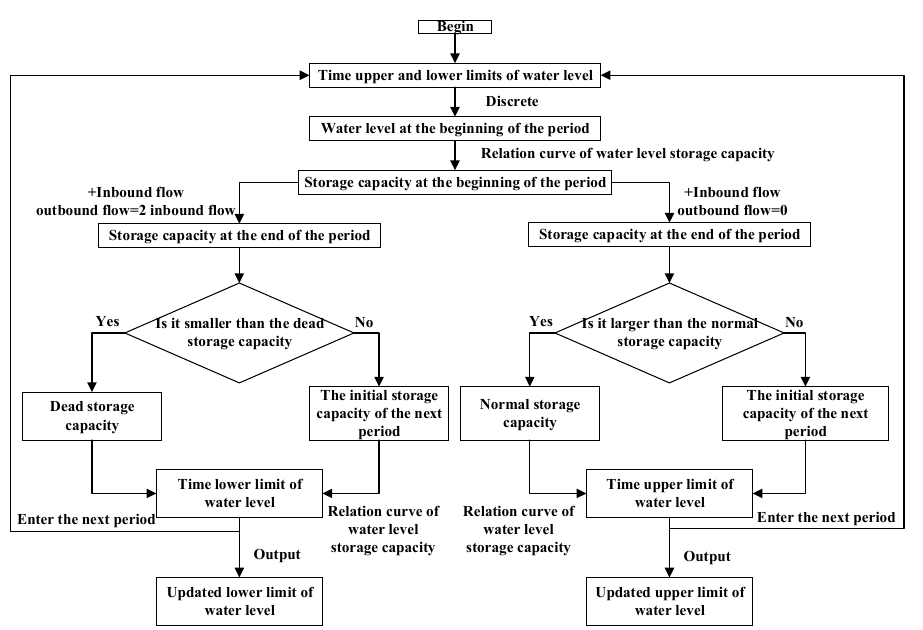
Figure 1. Flow chart for determining the upper and lower limits of the water level during the period.